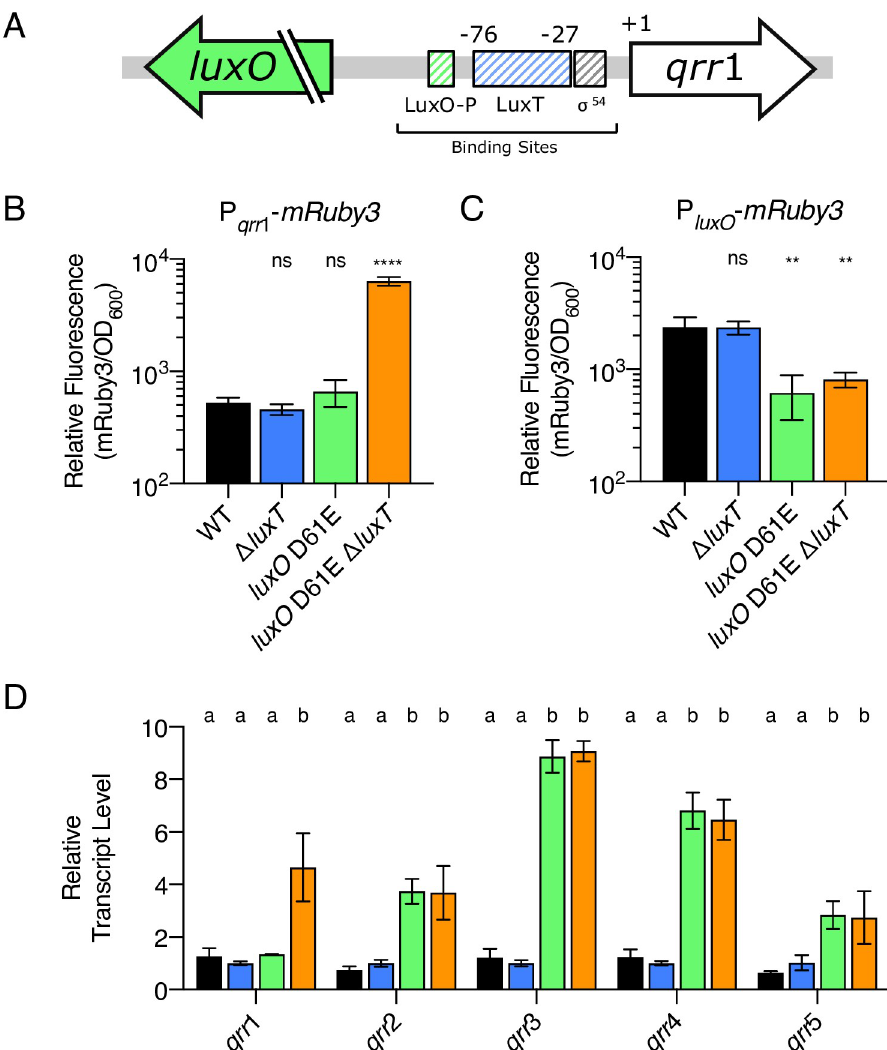
Fig 3. LuxT represses qrr 1 transcription. (A) Diagram of the luxO-qrr 1 locus. qrr 1 resides 151 bp upstream of luxO and is transcribed in the opposite direction. The striped green and gray boxes depict the putative LuxO-P and σ 54 binding sites, respectively. The striped blue box designates the previously identified LuxT binding region, which spans from -76 to -27 relative to the qrr 1 +1 transcriptional start site. (B) Relative fluorescence values (mRuby3/OD 600 ) of the - mRuby3 transcriptional reporter on a plasmid. Values represent relative indicated V . harveyi strains carrying a P qrr 1 fluorescence at OD 600 = 0.6. (C) As in B for strains harboring a P luxO -mRuby3 reporter. For B and C, unpaired two- tailed t tests with Welch’s correction were performed comparing mutants to WT. p values: ns � 0.05, �� < 0.01, ���� < 0.0001. (D) qRT-PCR measuring the indicated Qrr sRNAs at OD 600 = 1. Transcripts were measured in WT (black), Δ luxT (blue), luxO D61E (green), and luxO D61E Δ luxT (orange) V . harveyi . Different letters indicate significant differences between strains, p < 0.05 (two-way analysis of variation (ANOVA) followed by Tukey’s multiple comparisons test). For B, C, and D, error bars represent standard deviations of the means of n = 3 biological replicates.